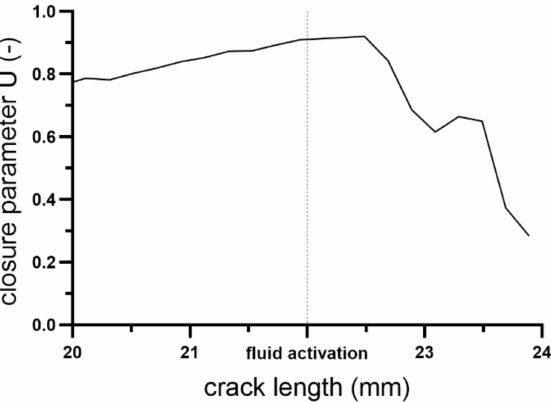
Figure 15. Elber closure parameter variation for “fluid” specimen before and after injection (including 2 mm crack length